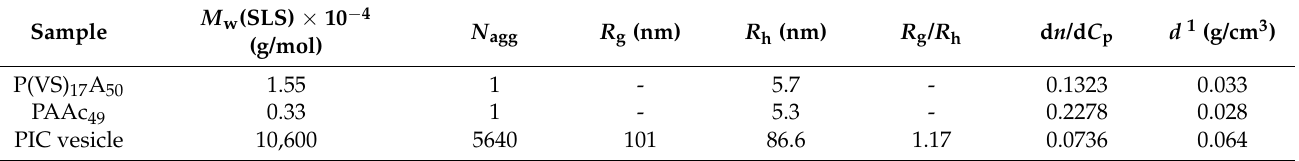
Table 2. Dynamic and static light scattering data for P(VS) 17 A 50 , PAAc 49 , and the P(VS) 17 A 50 /PAAc 49 PIC